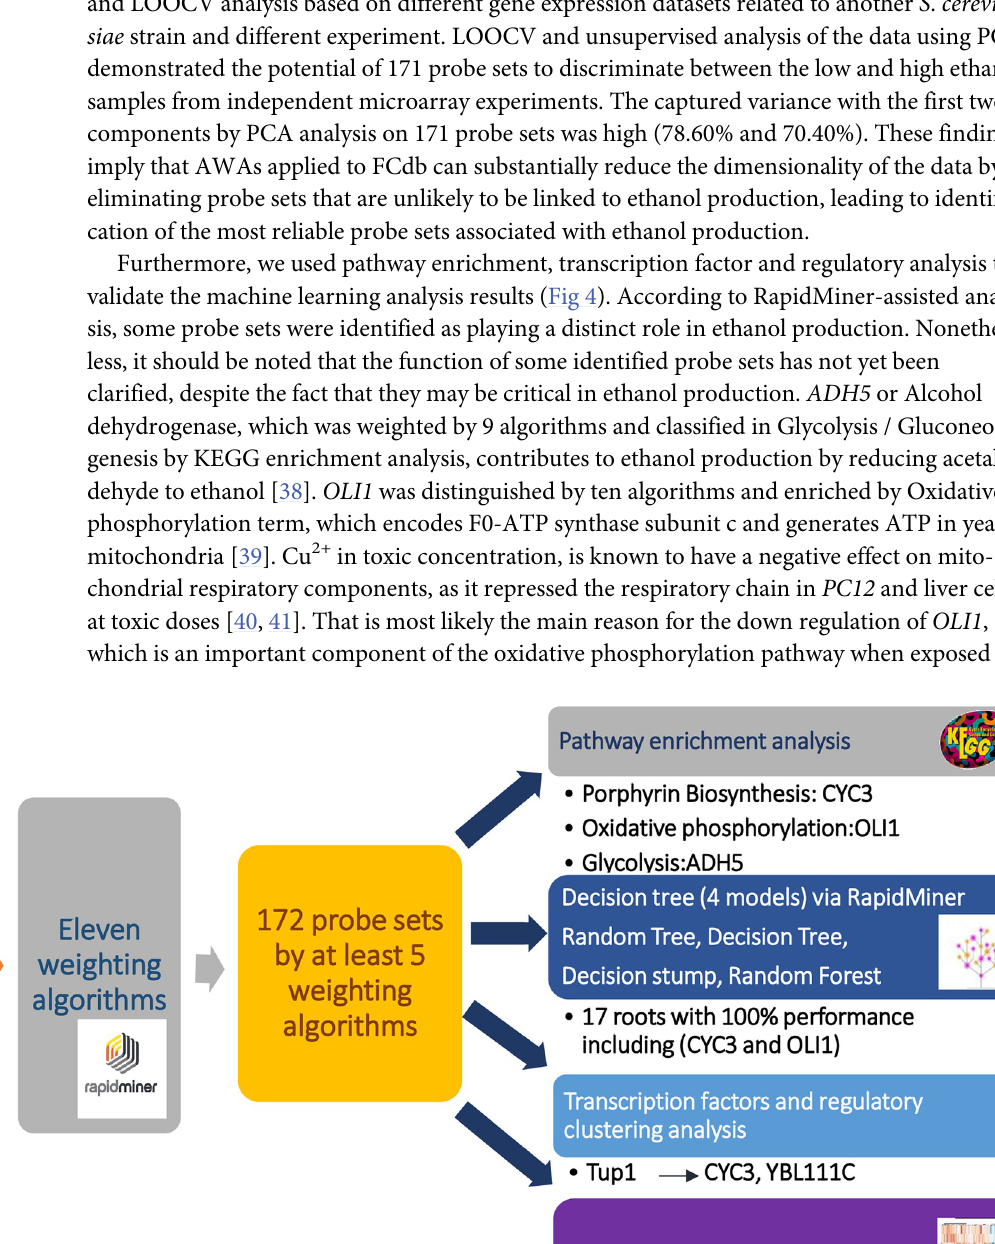
Fig 3. The regulatory clustering heatmap related to genes targeted by identified transcription factors Hap4p and Tup1 and TOS8 . The cluster is represented as the log mRNA ratio of each target gene in each regulator mutant.